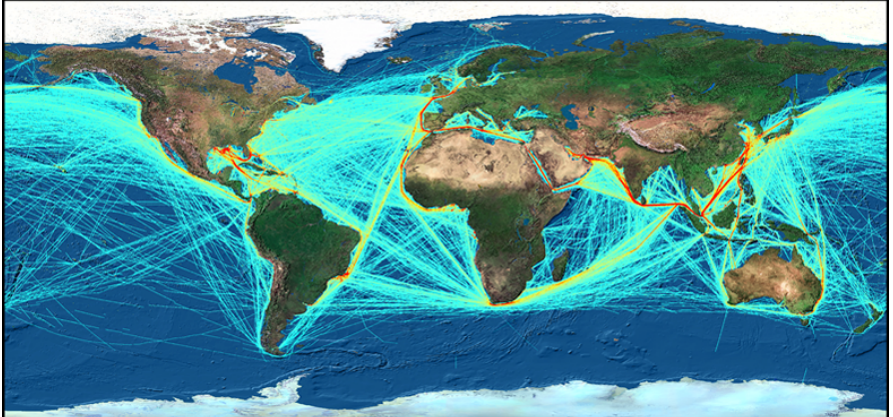
Figure 5. Monthly density plot for the total number of ships registered with Automated Mutual-Assistance Vessel Rescue System (AMVER) for July 2011. AMVER is sponsored by the United States Coast Guard and makes use of the global ship reporting system used worldwide by search and rescue authorities. The ship density plot is compiled from a 2011 average of 4634 ships per day (United States Coast Guard,